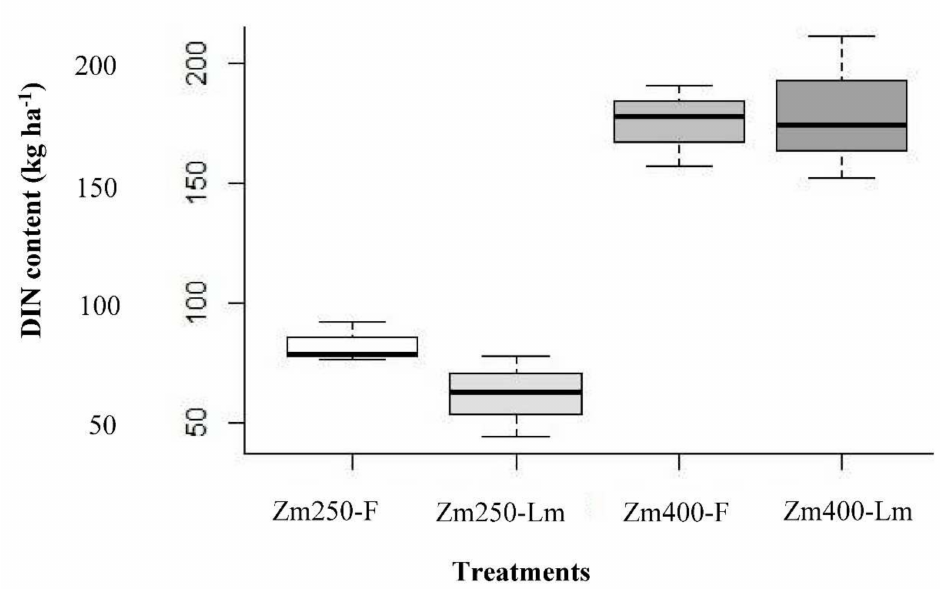
Figure 5. Dissolved inorganic nitrogen content (DIN) at the end of the maize season.